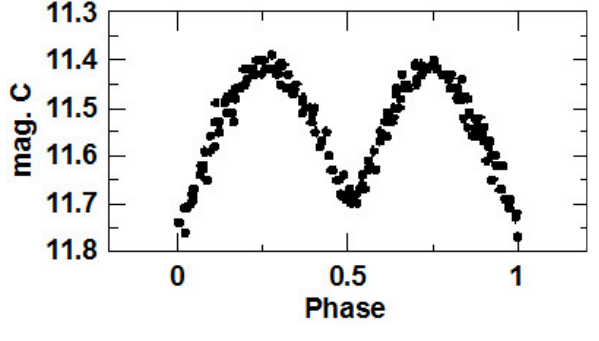
Fig. 1 The light curve of the binary IK Boo without filter given by Blättler in